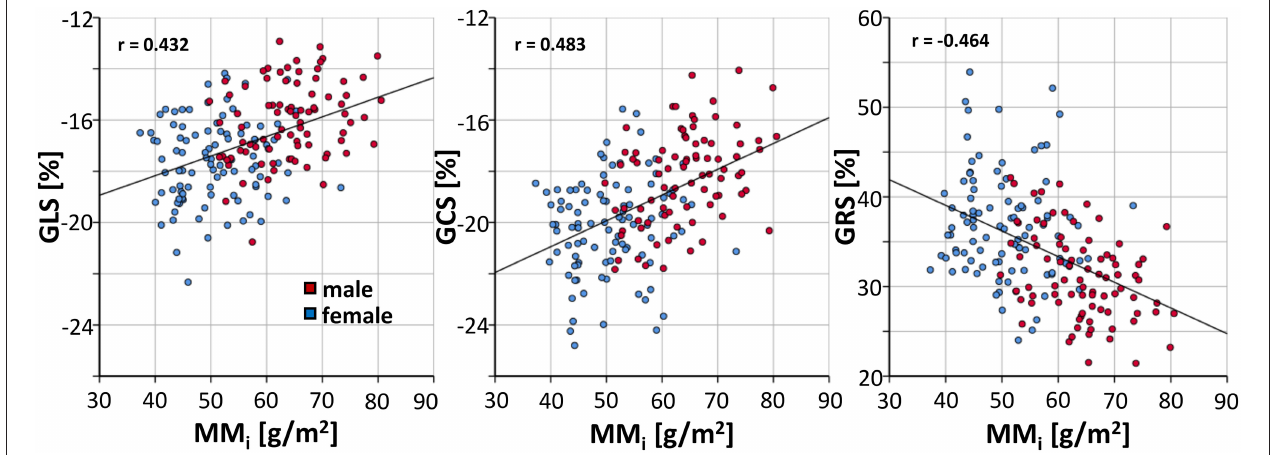
FIGURE 5 | Correlation of indexed muscle mass and FT strain values in healthy subjects. GLS, global longitudinal strain; GCS, global circumferential strain; GRS global radial; MM i , indexed muscle